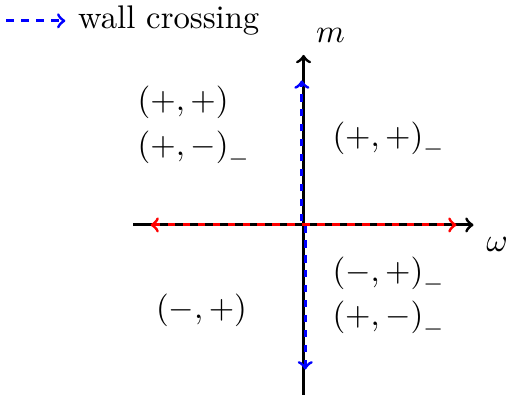
Figure 1. Phase diagram of the classical theory. The blue line denotes a wall crossing and the red line a phase